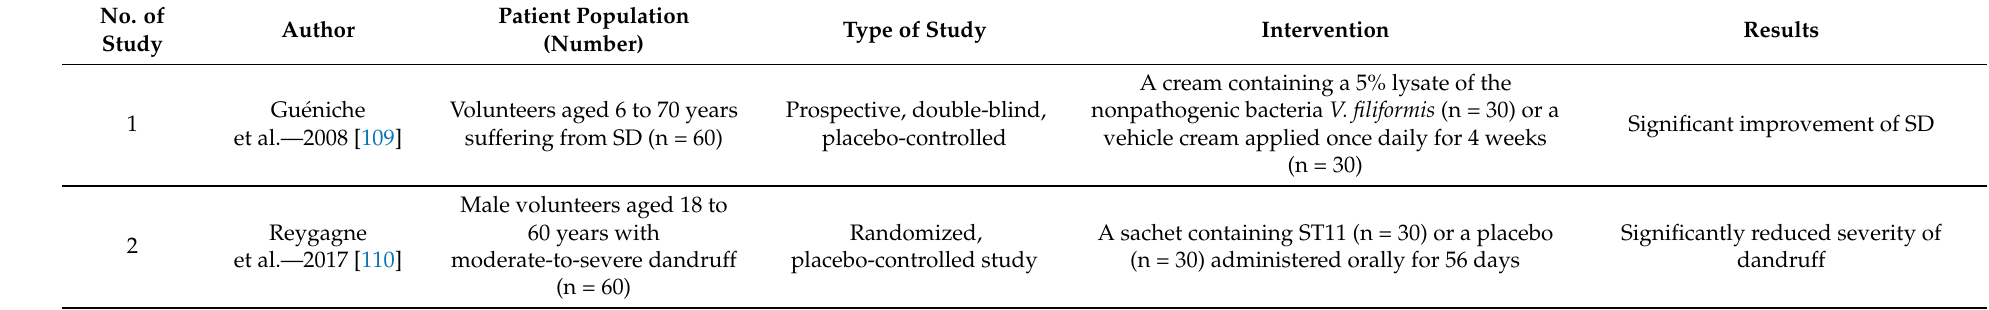
Table 8. Probiotic treatment in SD.